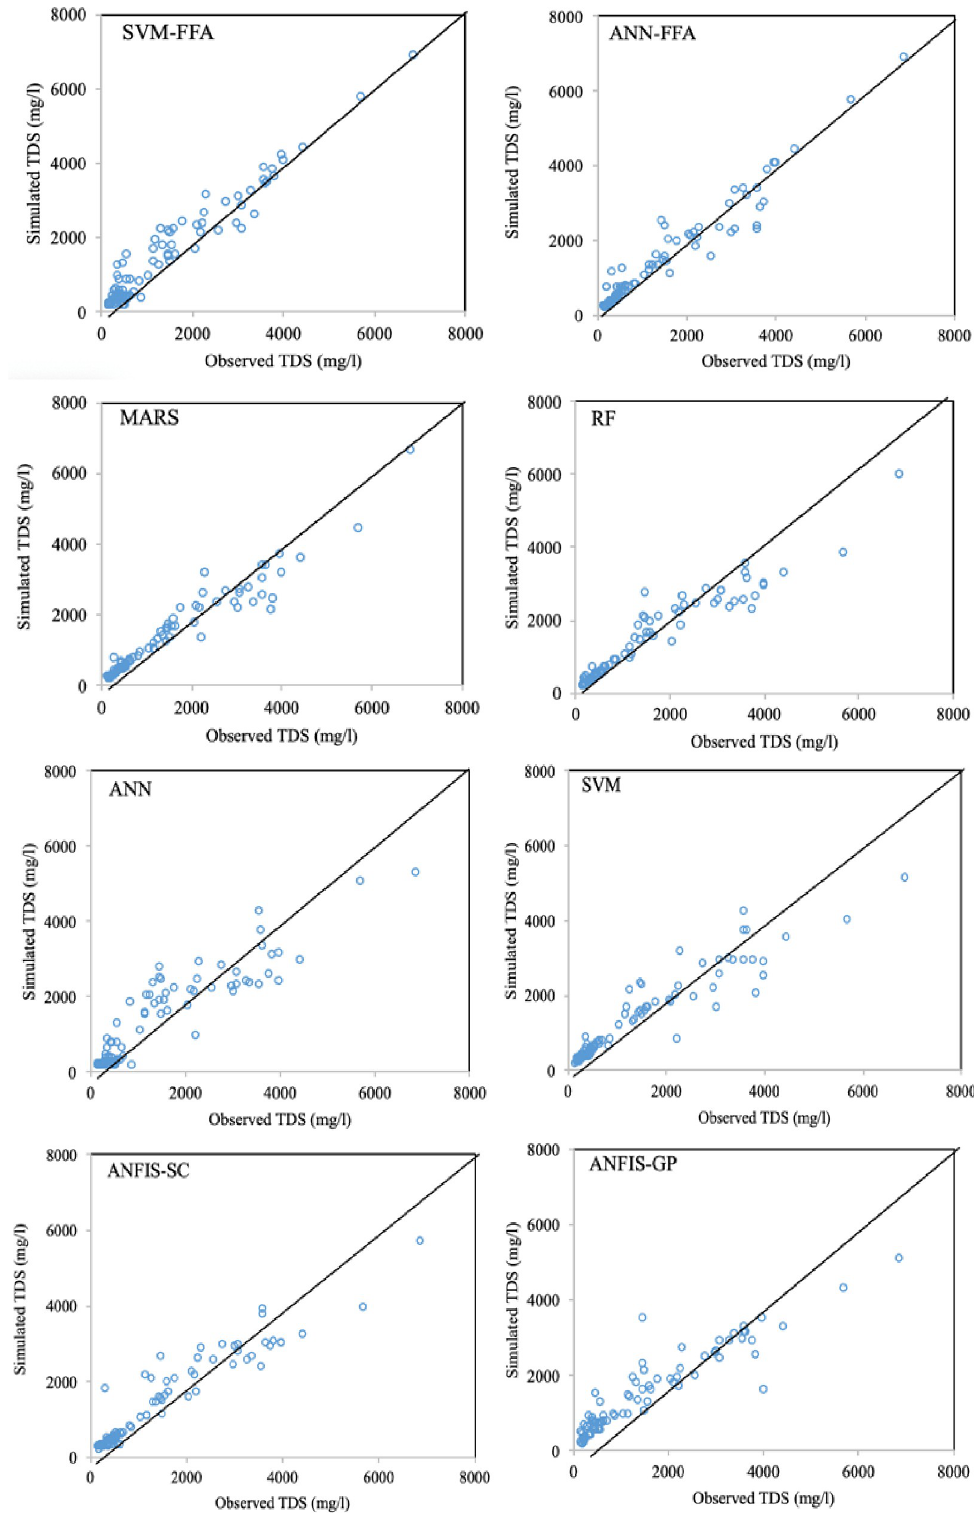
Fig 8. The scatterplots of the predicted TDS using the applied AI models.